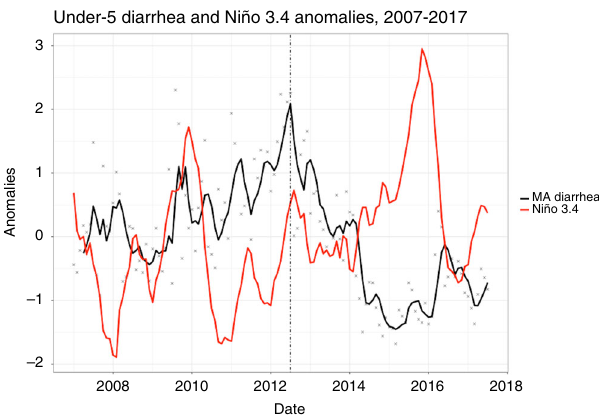
Fig. 5 Under-5 diarrhea and Niño 3.4 anomalies from 2007 to 2017. Diarrhea anomalies are shown as gray crosses, a moving average of diarrhea anomalies is shown in black, and Niño 3.4 anomalies (Kelvin) are in red. The moving average was calculated using the mean of each observation with the three previous observations. The rotavirus vaccine was introduced in July, 2012, which is shown as a dashed-dotted